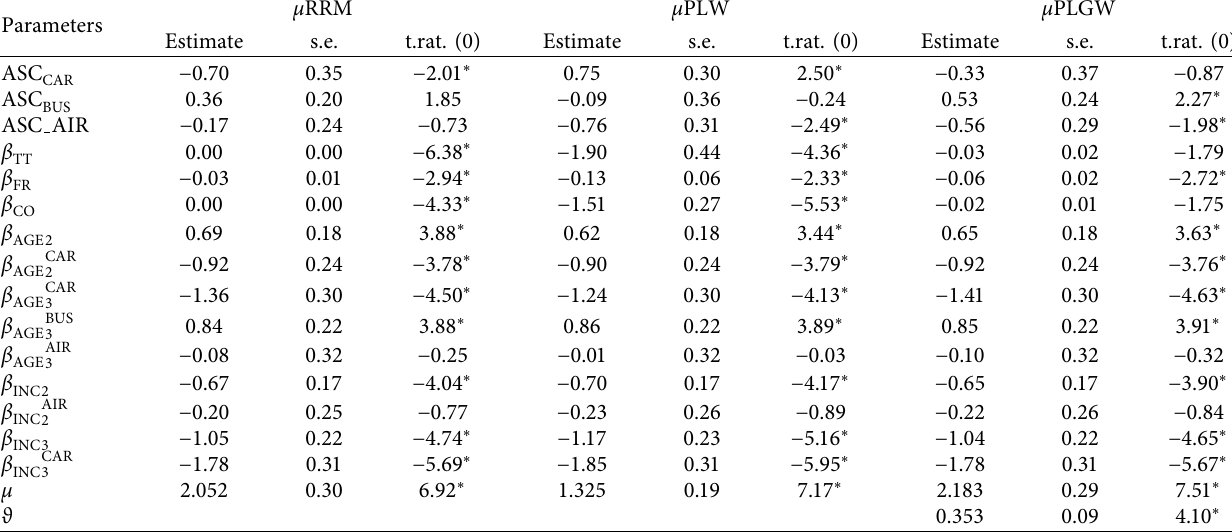
Table 9: Estimates of the μ RRM, μ PLW, and μ PLGW for business purpose of the HSR experiment. μ RRM μ PLW μ PLGW Parameters